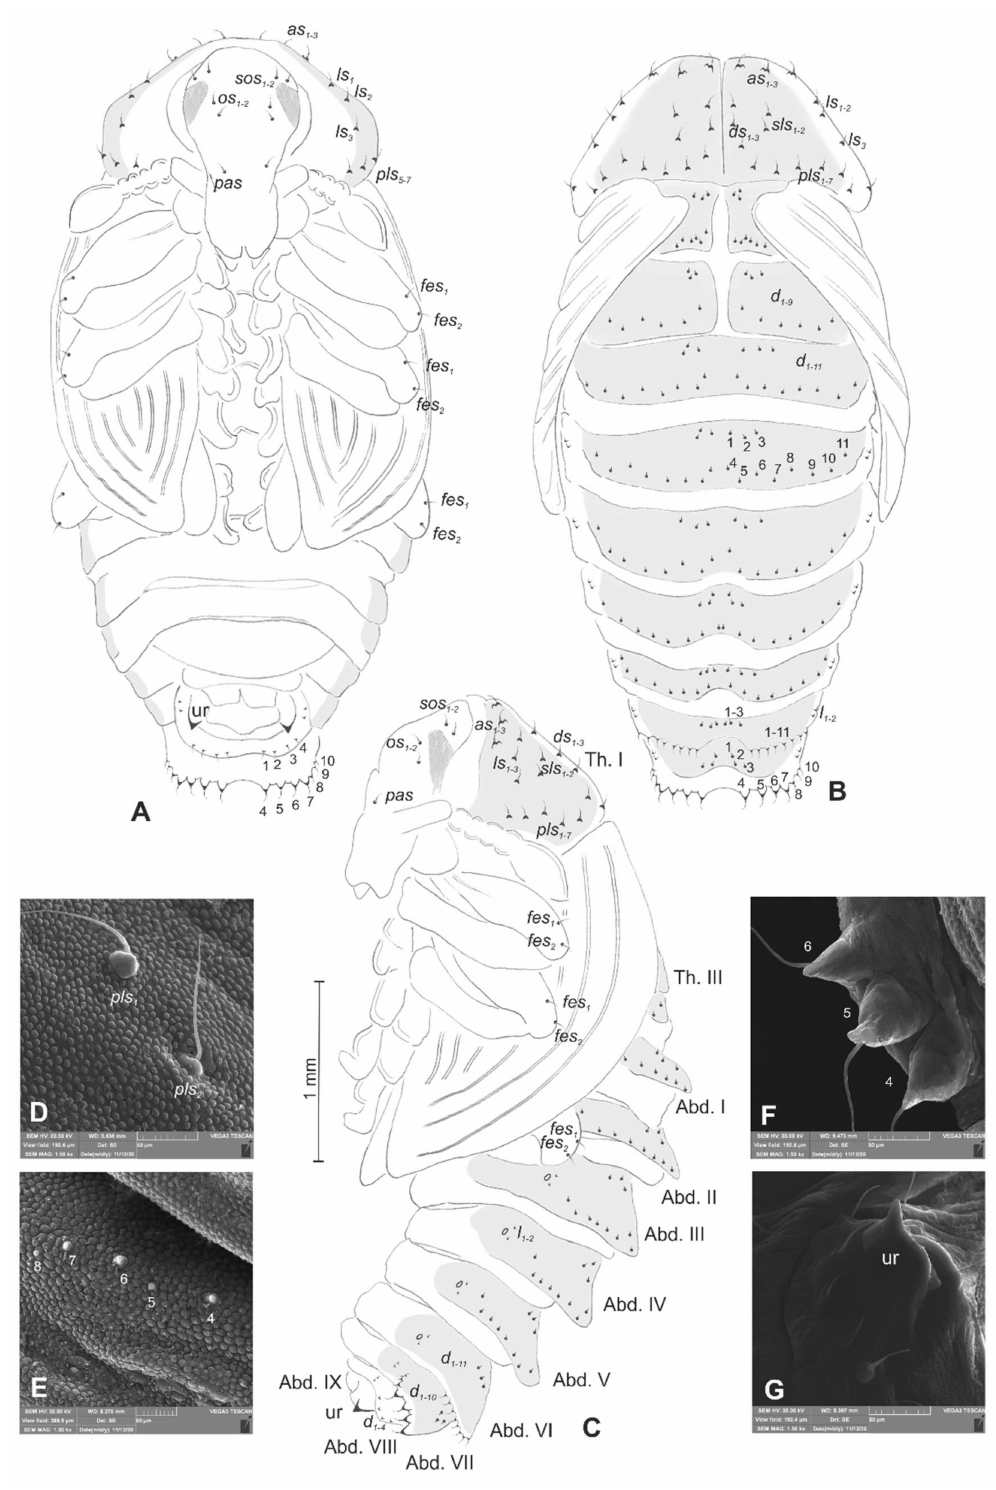
Figure 10. Lachnaeus crinitus pupa. ( A )—ventral view; ( B )—dorsal view; ( C )—lateral view; ( D )—pronotum, dorsal view, magnification; ( E )—Abd. I, dorsal view, magnification; ( F )—Abd. VII, dorsal view, magnification; ( G )—urogomphus, magnification (Th. I–III—pro-, meso- and metathorax, Abd. I–IX—abdominal segments 1–9, ur—urogomphus, setae: as —apical, d —dorsal, ds —discal, fes —femoral, ls —lateral, os —orbital, pas —postantennal, pls —posterolateral, rs —rostral, sls